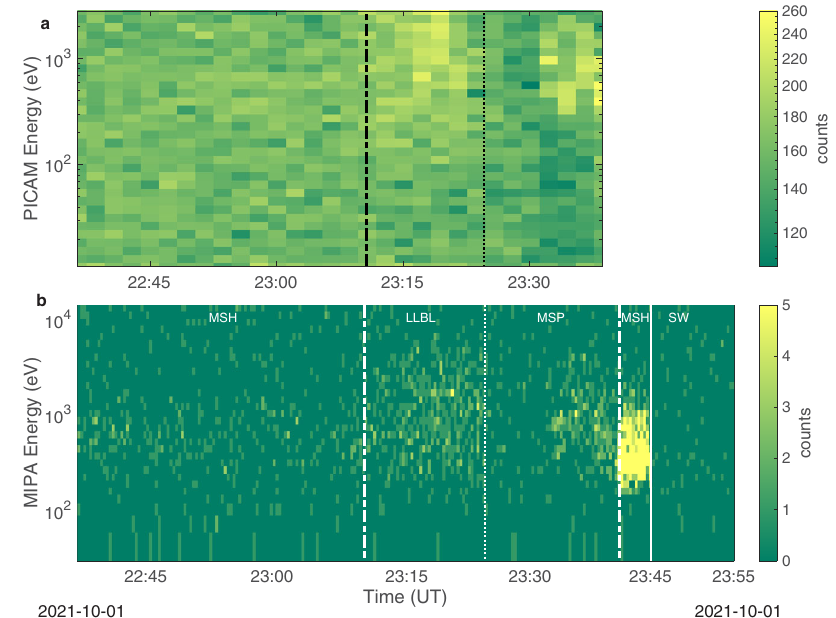
Fig. 5| MFB1PICAM and MIPAspectrogramsinside Mercury ’ s magnetosphere. Thespectrogramsobtainedby a PICAMobservationsand b MIPAmeasurementsin the inner magnetosphere of Mercury. The dashed-dotted lines refer to the expec- ted inbound and outbound magnetopause crossings, the dotted lines refer to the observed transition from low latitude boundary layer to the magnetospheric dusk